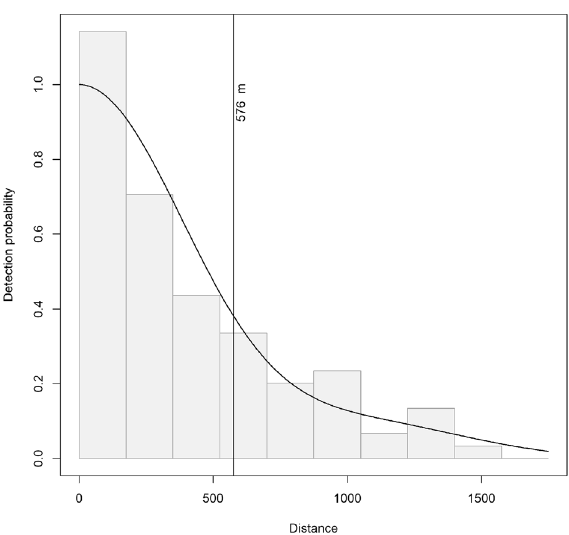
Figure 6. Detection function for selected model c1. The detection function chosen as the best model was a half- normal key function using a cosine series adjustment of order 2 and no additional sighting covariates. Effective strip width was estimated at 576